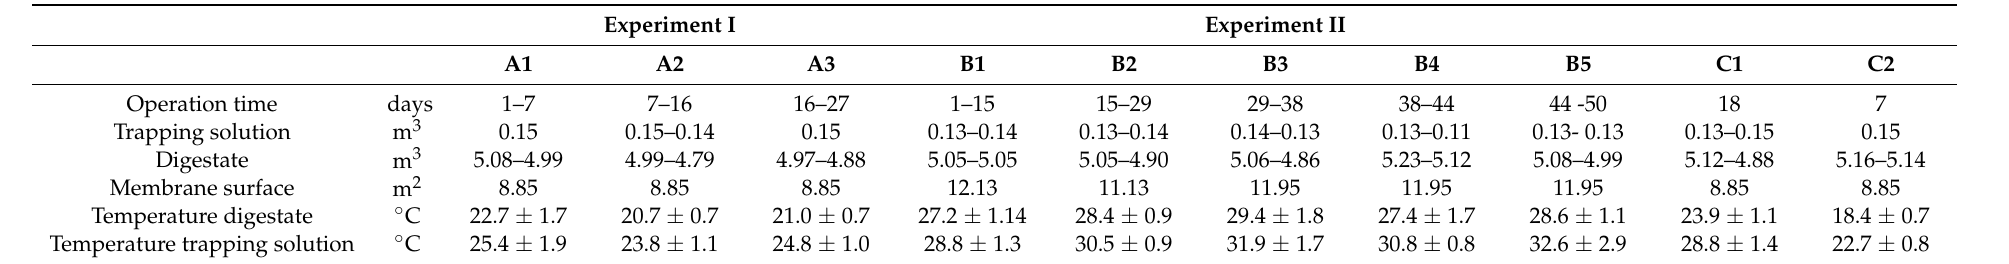
Table 2. Operational parameters during Experiment I (A1–A3), Experiment II (B1–B5) and two batches